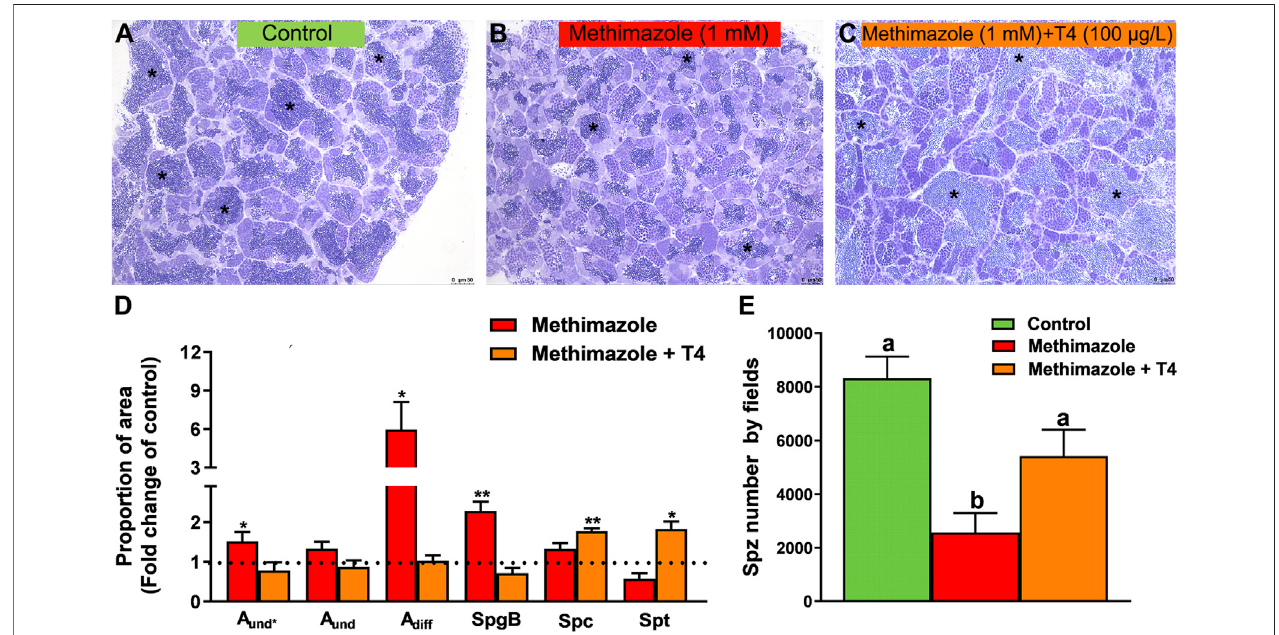
FIGURE 2 | Histomorphometrical evaluation of zebra fi sh testes after in vivo exposure to methimazole and co-treatment with T4 for 3 weeks. Control group (non- treated fi sh) (A) . Methimazole-treated group (B) . Methimazole co-treated with T4 (C) . Asterisks in (A) , (B) and (C) indicate the testicular lumen with spermatozoa that appeared reduced in the methimazole group. (D) Proportion of section area occupied by different spermatogenic cysts: type A undifferentiated spermatogonia (A und* , A und ), type A differentiated spermatogonia (A diff ), type B spermatogonia (SpgB), spermatocytes (Spc), and spermatids (Spt). Bars (mean ± SEM; n = 8) are expressed as fold-change relative to the no-treated fi sh (control group) (dotted black line set at 1). (E) Spermatozoa number per fi eld generated by using IMAGEJ Softwarefromcontrolandtreatments.ANOVAfollowedbyDunnett ’ smultiplecomparisontests.Distinctlettersdenotesigni fi cantdifferences( p < 0.05)betweendifferent treatment conditions with the untreated group. Asterisks denote statistical signi fi cance differences between control, methimazole and methimazole + T4 groups; *p < 0.05 ; **p < 0.01 (Student unpaired t -test; n = 8). Staining: Toluidine blue. Scale bar = 50